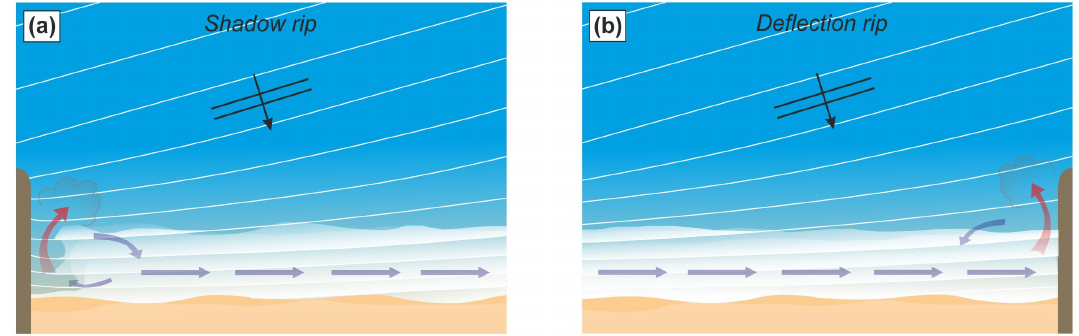
Figure 1. Schematics of the forcing mechanisms driving boundary rips which flow against rigid lateral boundaries such as natural headlands or anthropogenic structures: ( a ) schematic of a shadow rip in the lee of an obstacle (upwave side); ( b ) deflection rip adjacent to obstacle on downwave side of